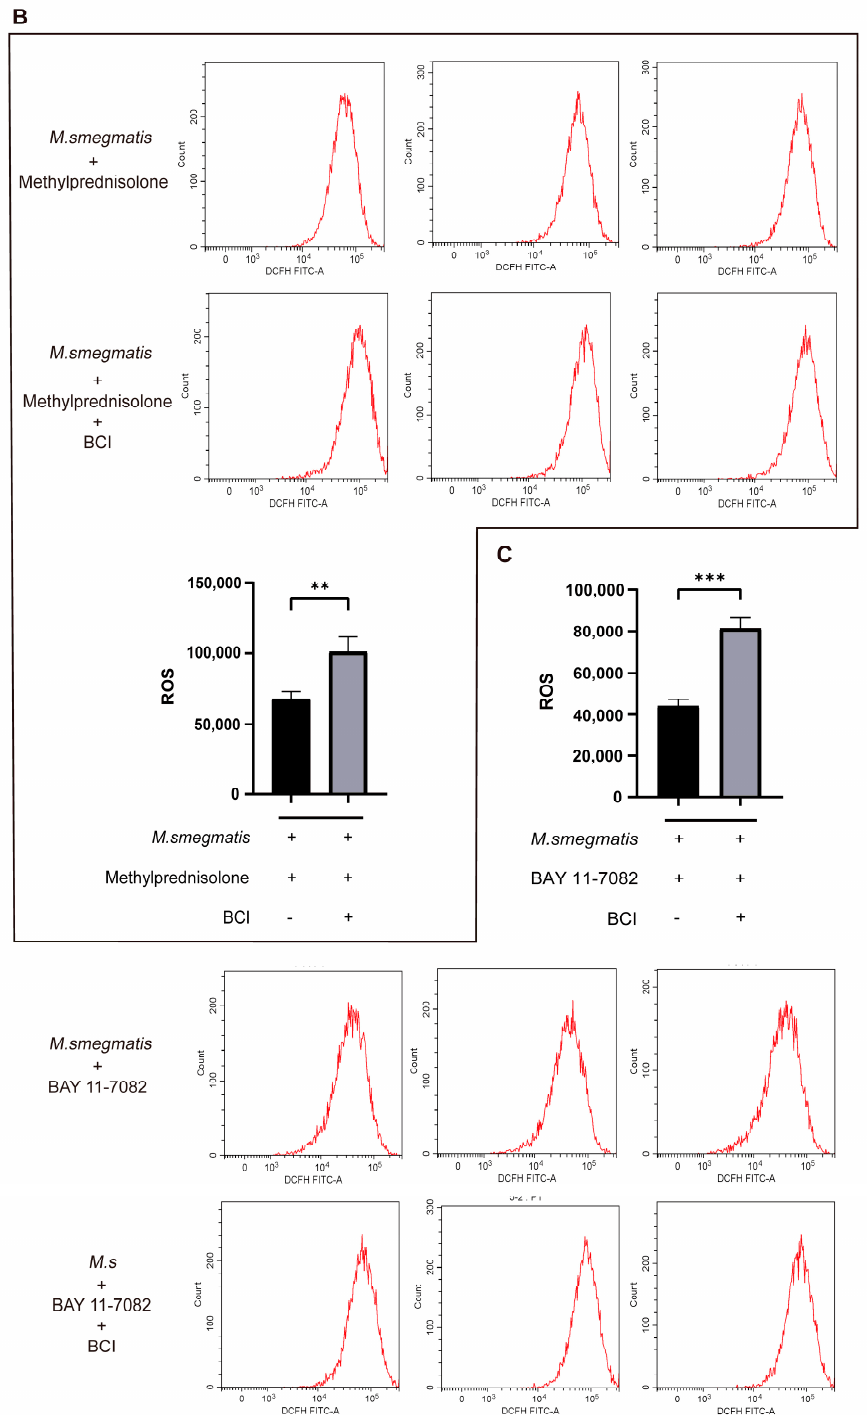
Figure 8. ( A ) BCI (1 µ M) treated M. smegmatis infected RAW264.7 cells for 48 h; flow cytometry was used to detect the level of cellular ROS production; the t-test was used for data analysis; ** p < 0.01. ( B ) Methylprednisolone (10 2 µ M) and BCI (1 µ M) treated M. smegmatis infected RAW264.7 cells for 48 h; flow cytometry was used to detect the level of cellular ROS production; the t-test was used for data analysis; ** p < 0.01. ( C ) BAY 11-7082 (2 µ M) and BCI (1 µ M) treated M. smegmatis infected RAW264.7 cells for 48 h; flow cytometry was used to detect the level of cellular ROS production; the t -test was used for data analysis; *** p < 0.001.